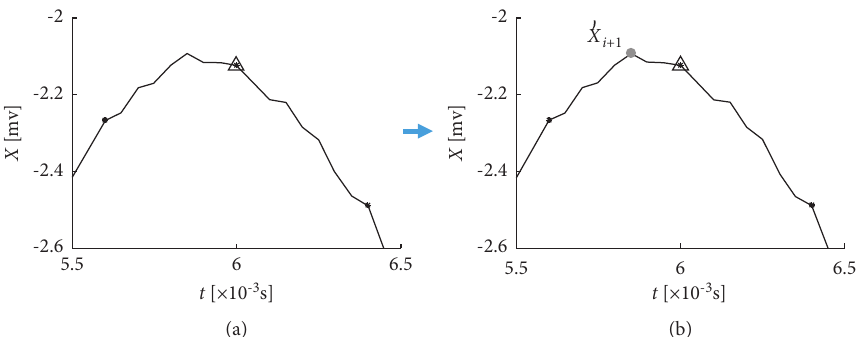
Figure 5: Local resampling result: (a) local resampling sequence and (b) the extracted pulse phase point.